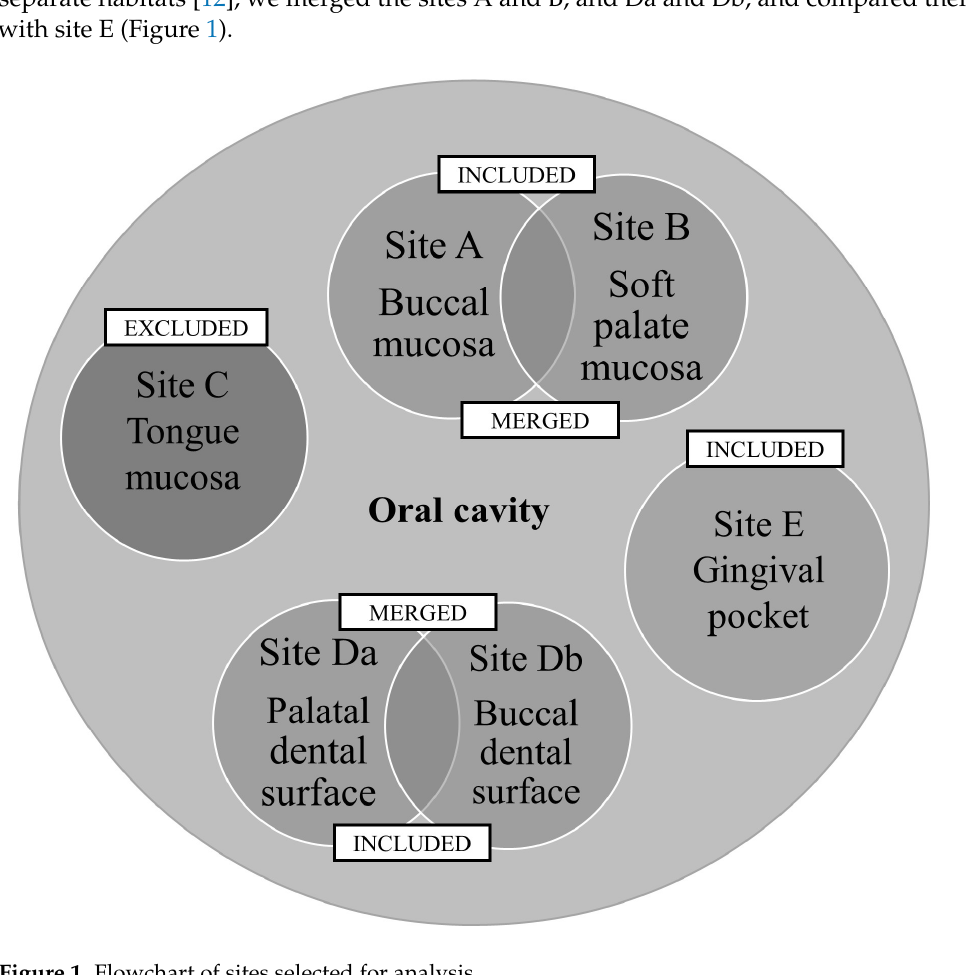
Figure 1. Flowchart of sites selected for analysis.